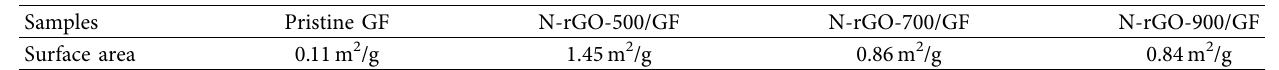
Figure 4: Surface morphology of N-rGO-modified GF electrode (a) and detailed view of the N-rGO absorbed on GF electrode. The red arrow in Figure 4 (b) points to the absorbed N-rGO. Table 1: BET surface area of different types of N-rGO-modified